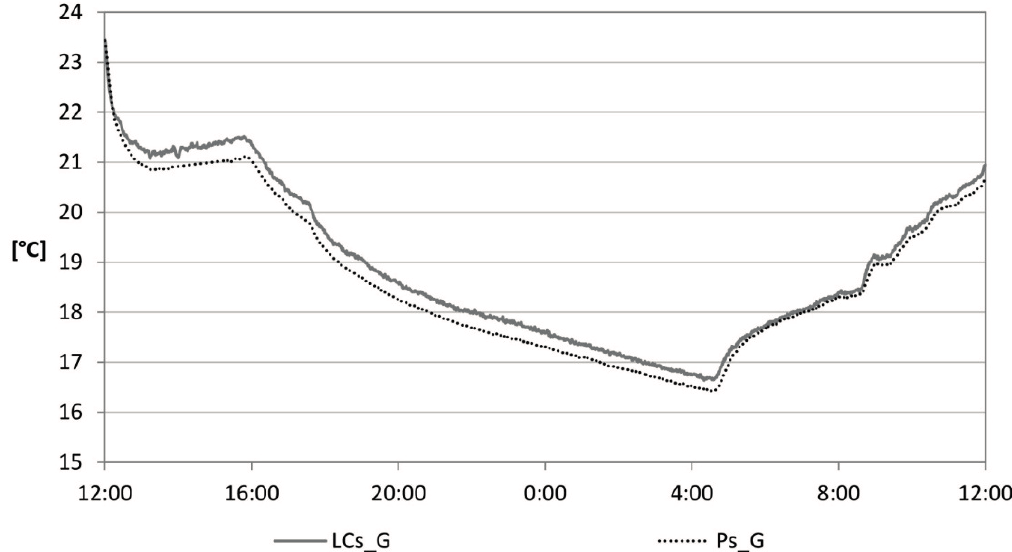
Figure 8. Radiant temperature.